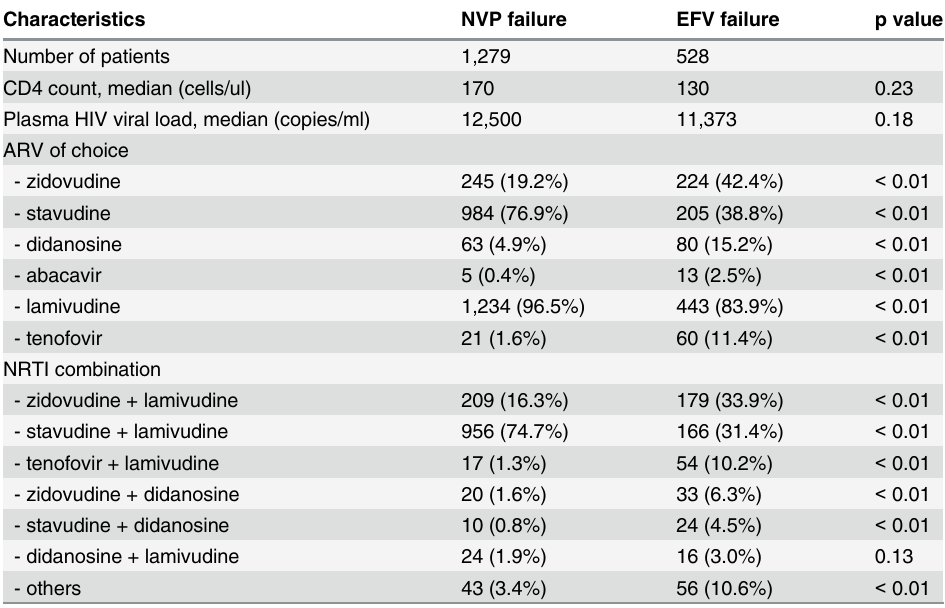
Table 1. Baseline characteristics of the